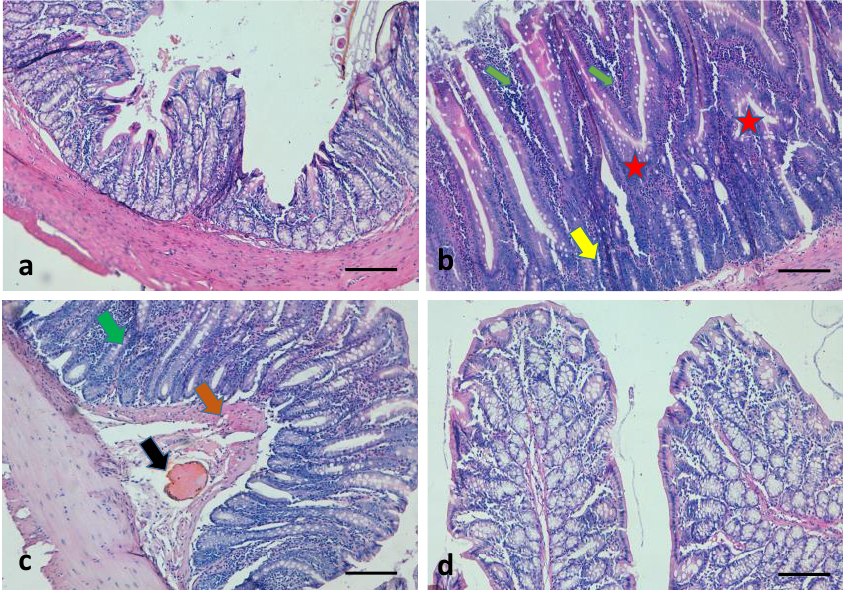
Figure 4. The colon protective role of 6-gingerol in different treatment groups. ( a ) control group showing normal architecture of the colon tissue, ( b ) AOM treated colon cancer group. The mucosal glands are irregular in size and shape (red star), hyperchromatic with severe aggregation of inflammatory cells (green arrow) and alteration of normal structure (yellow arrow). ( c ) AOM plus 6-gingerol group, colon cancer not found; however, inflammation (green color), congestion (black color) and fibrosis are seen (reddish orange), ( d ) 6-gingerol only treated group, showing normal architecture of colon tissue, ( n = 8 animals/group) (Scale bar = 100 µ m).